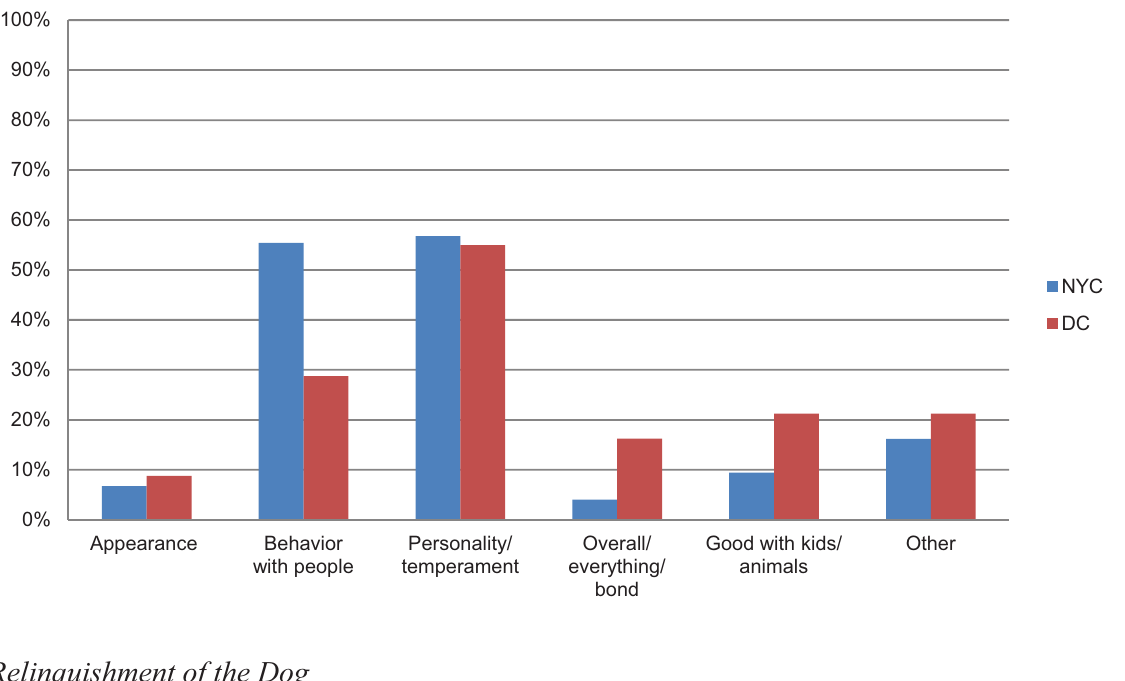
Figure 2. Comparison of dog characteristics most favored by owners after several months of ownership in New York City and Washington,